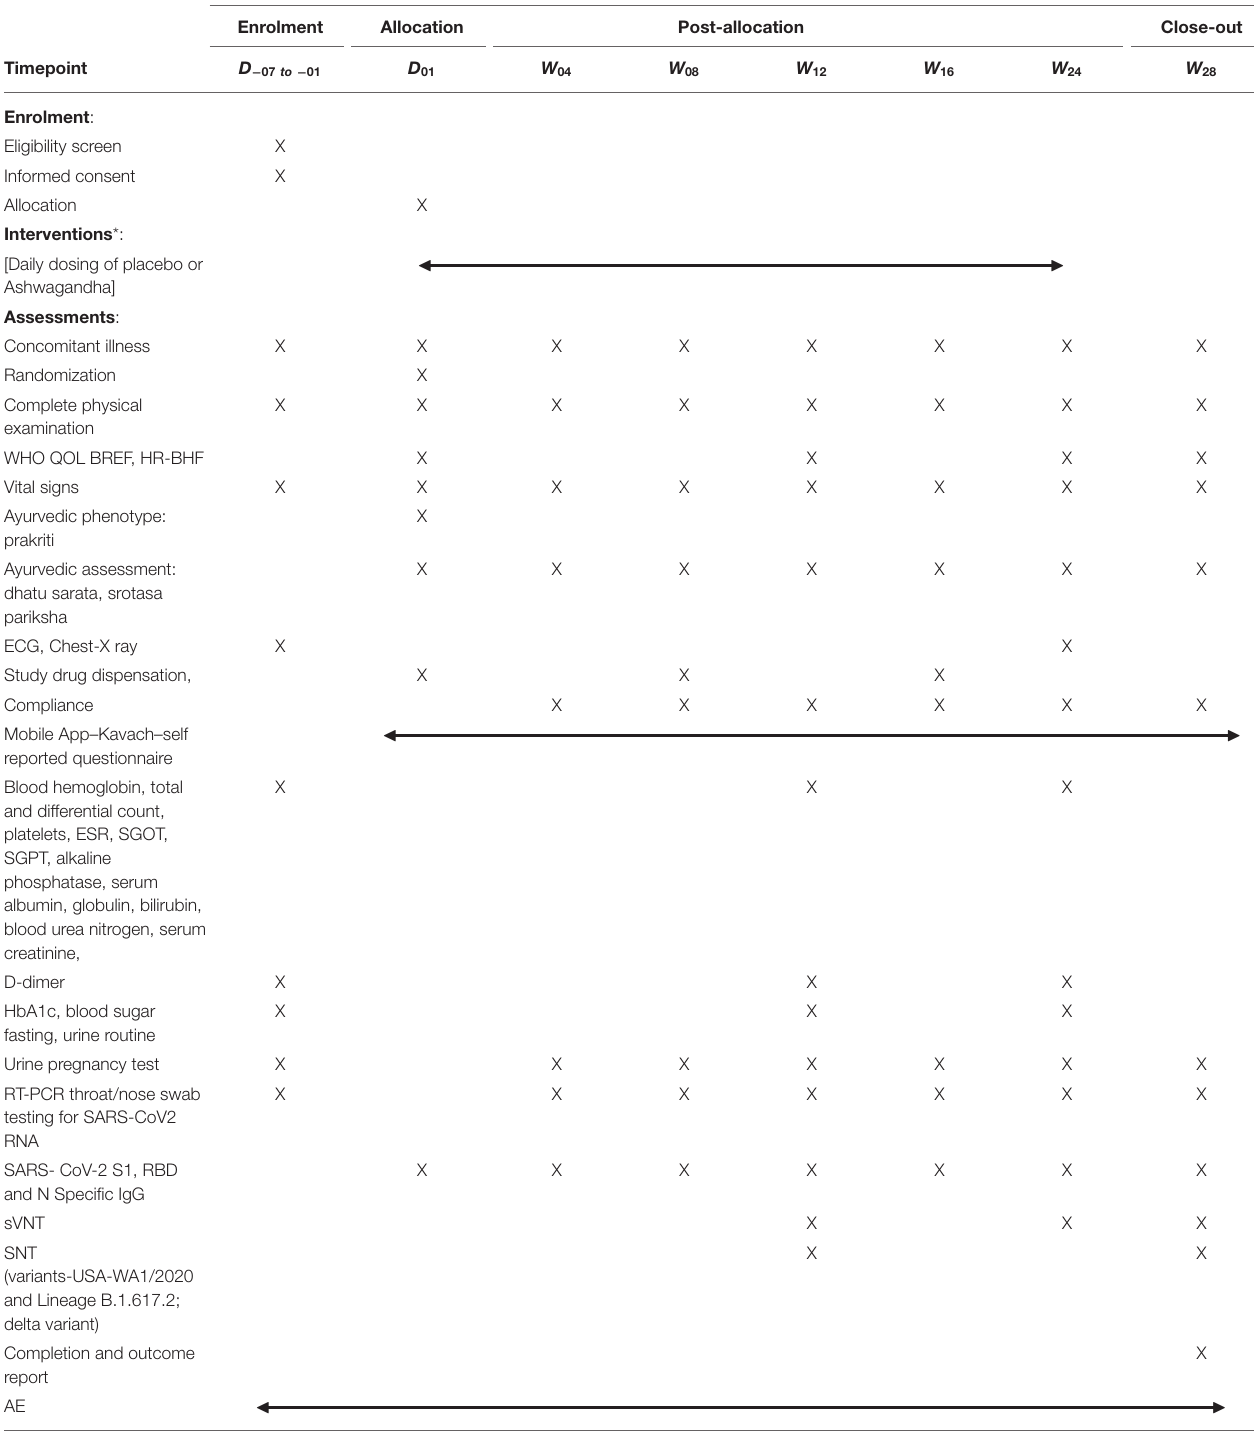
Additional studies on measurement of secretory IgA and T cell responses are planned on a subset of the